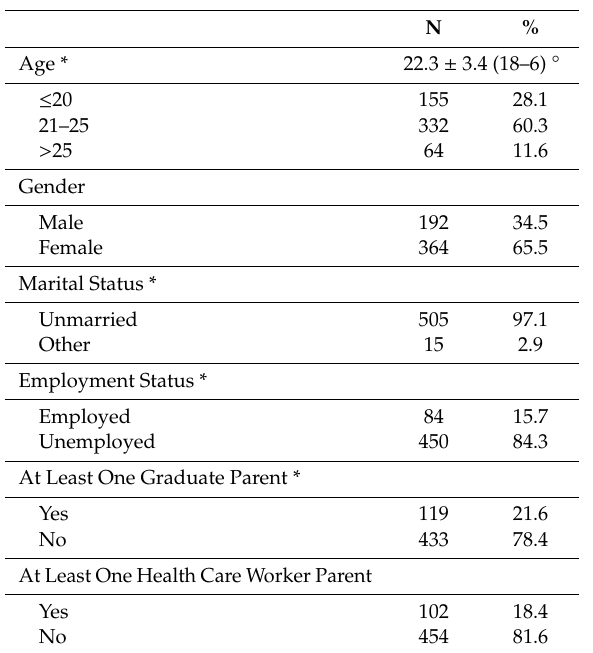
Table 1. Socio-demographic characteristics about the study